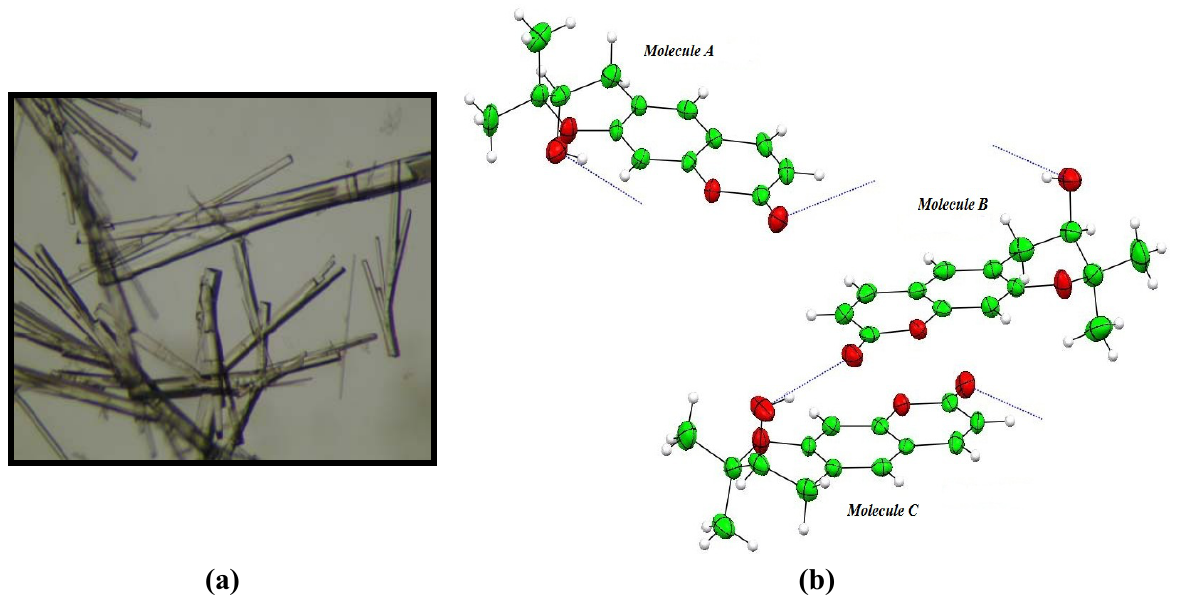
Figure 2. ( a ) Morphology of crystals of aegelinol ( 1 ) obtained by slow evaporation from a solution in ethanol; ( b ) Conformation of the three independent molecules in the asymmetric unit showing thermal motion (ORTEP, 30% probability).